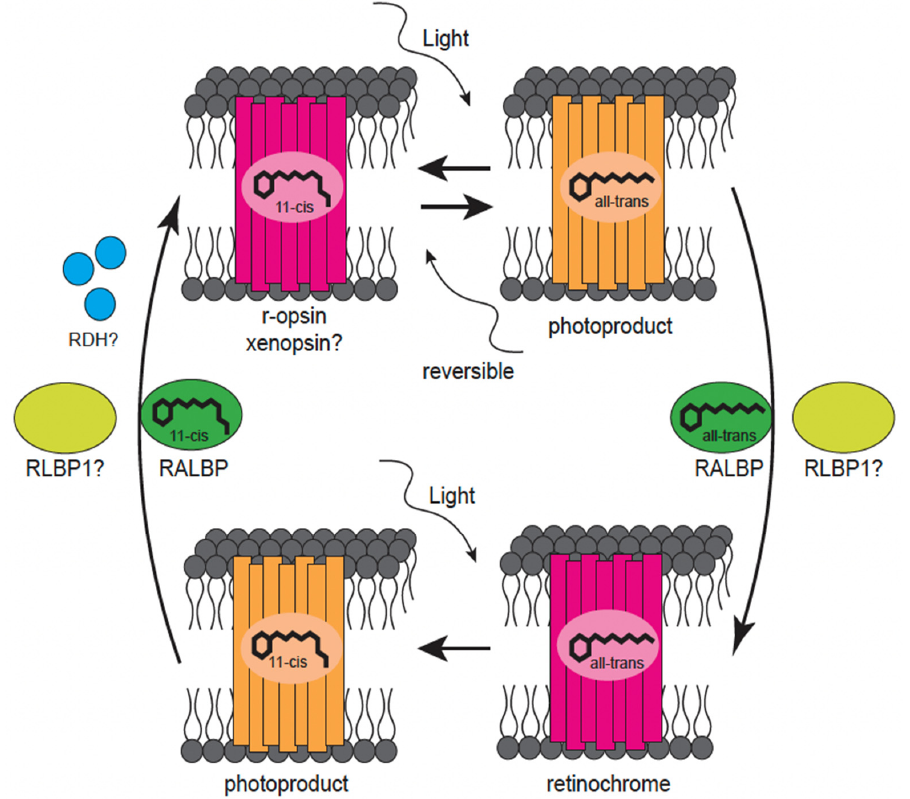
Figure 4. The rhodopsin-retinochrome system. Mostly known from cephalopods, in the rhodopsin- retinochrome system 11- cis retinal is bound to an r-opsin and changes its conformation upon light absorption to all- trans retinal. Then all- trans retinal either remains bound to the bistable r-opsin or leaves the r-opsin and binds to RALBP, which transports it to retinochrome. Bound to retinochrome, retinal changes back to the 11- cis conformation upon light detection. Finally, 11- cis retinal binds again to RALBP and is transported back to the r-opsin to complete the cycle. However, recent stud- ies indicate more complexity, suggesting the involvement of further proteins, including a potentially monostable xenopsin, the transporter protein RLBP1 and RDH enzymes. However, their actual con- tributions remain speculative and still need to be determined by functional analyses (adapted from Koyanagi and Terakita 2014 [77]). 8. Cnidaria Visual Cycle Cubozoan opsins, similar to vertebrate opsins, undergo bleaching, suggesting pres- ence of a visual cycle that has yet to be described [172]. There is no cnidarian opsin that groups closely with known photoisomerases RGR or retinochrome [30,118]. It could be that a cnidopsin gene is co-opted as a photoisomerase, but that remains to be validated. In Tripedalia , an antibody against a cnidopsin detected protein in all eye types, suggesting a function as a photoisomerase [13]. Although specific photoisomerase genes are yet un- proven in cnidarians, cnidarians possess homologs of genes used in other animals for chromophore transport. We found two members of the SEC14-like family (protein 2 and protein 5) that have similar expression in all tissues (Table 1; Figure S11). In addition to finding homologs of clavesin/RLBP1 (Figure S12), we also found a cnidarian-specific gene family whose top BLAST results match RLBP1 , so we refer to these genes as RLBP1-like (Figure S13). These genes are expressed at higher levels in the rhopalia of Aurelia and Tri- pedalia and of RLBP1-like in the tentacles of Hydra and Sarsia (Figure S3). RLBP1-like was detected in cnidarians, in a recent paper, but the amino acids necessary in other animals for retinal binding were lacking, so it may not be involved in the visual cycle [118]. For